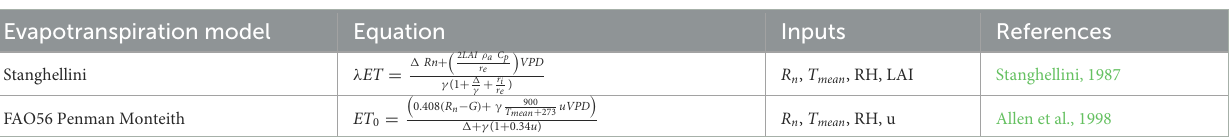
TABLE 4 Combination-based ET